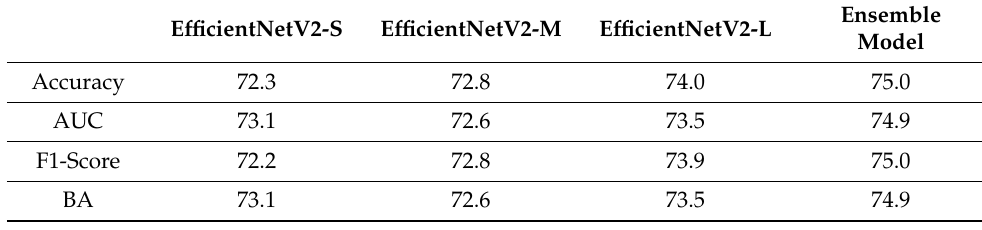
Table 4. Performance metrics for QE of all test set images for individual EfficientNetV2 models and their ensembling (all the values are in percentages). BA: balanced accuracy, AUC: area under the curve, QE: quality